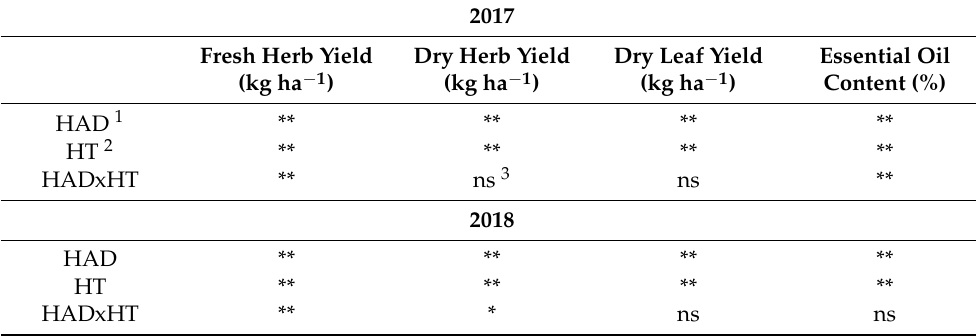
Table 2. Analysis of variance of HAD and HT on fresh herb yield (kg ha − 1 ), dry herb yield (kg ha − 1 ) and dry leaf yield (kg ha − 1 ) of O. vulgare subsp. hirtum L. in 2017 and 2018.